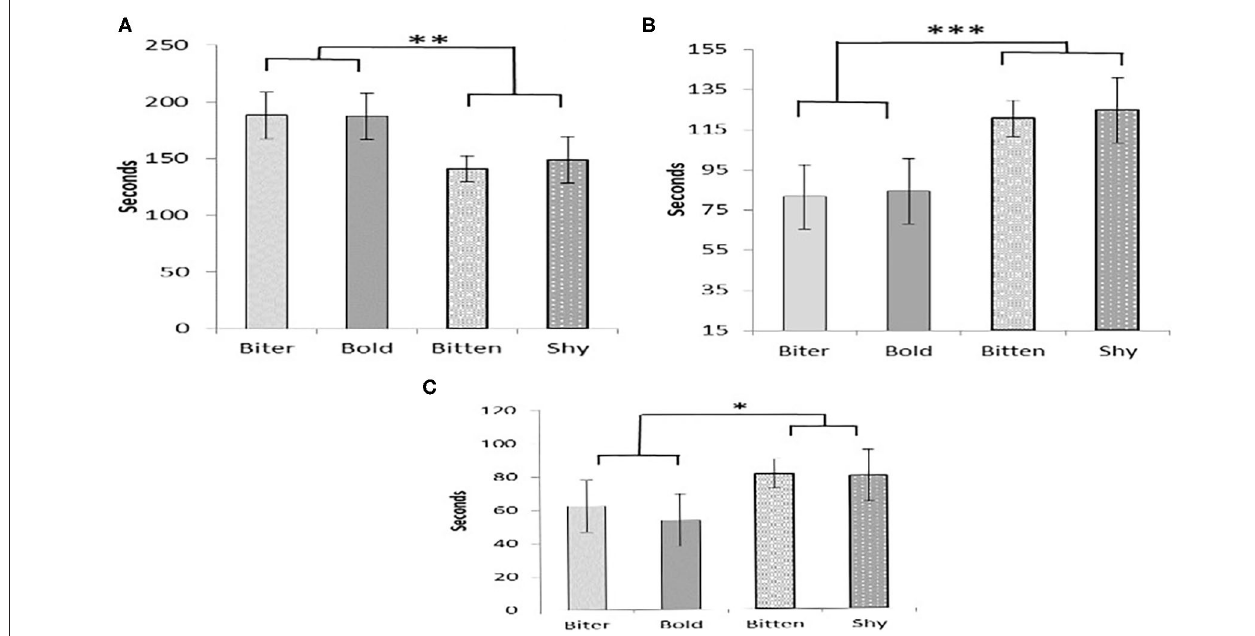
FIGURE 1 | The amount of time pigs in each category spent exploring (A) , by the door (B) , and standing still (C) . Tendencies and significant differences between BITER and BOLD with BITTEN and SHY pigs are indicated by * = 0.5 < P ≤ 0.1; ** = 0.01 < P ≤ 0.05, *** = 0.001 < P ≤ 0.01.